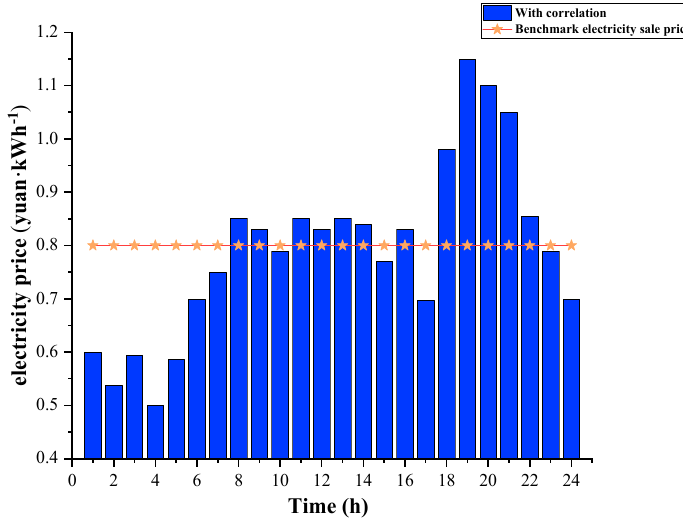
Figure 10. Optimal real-time pricing of EH.